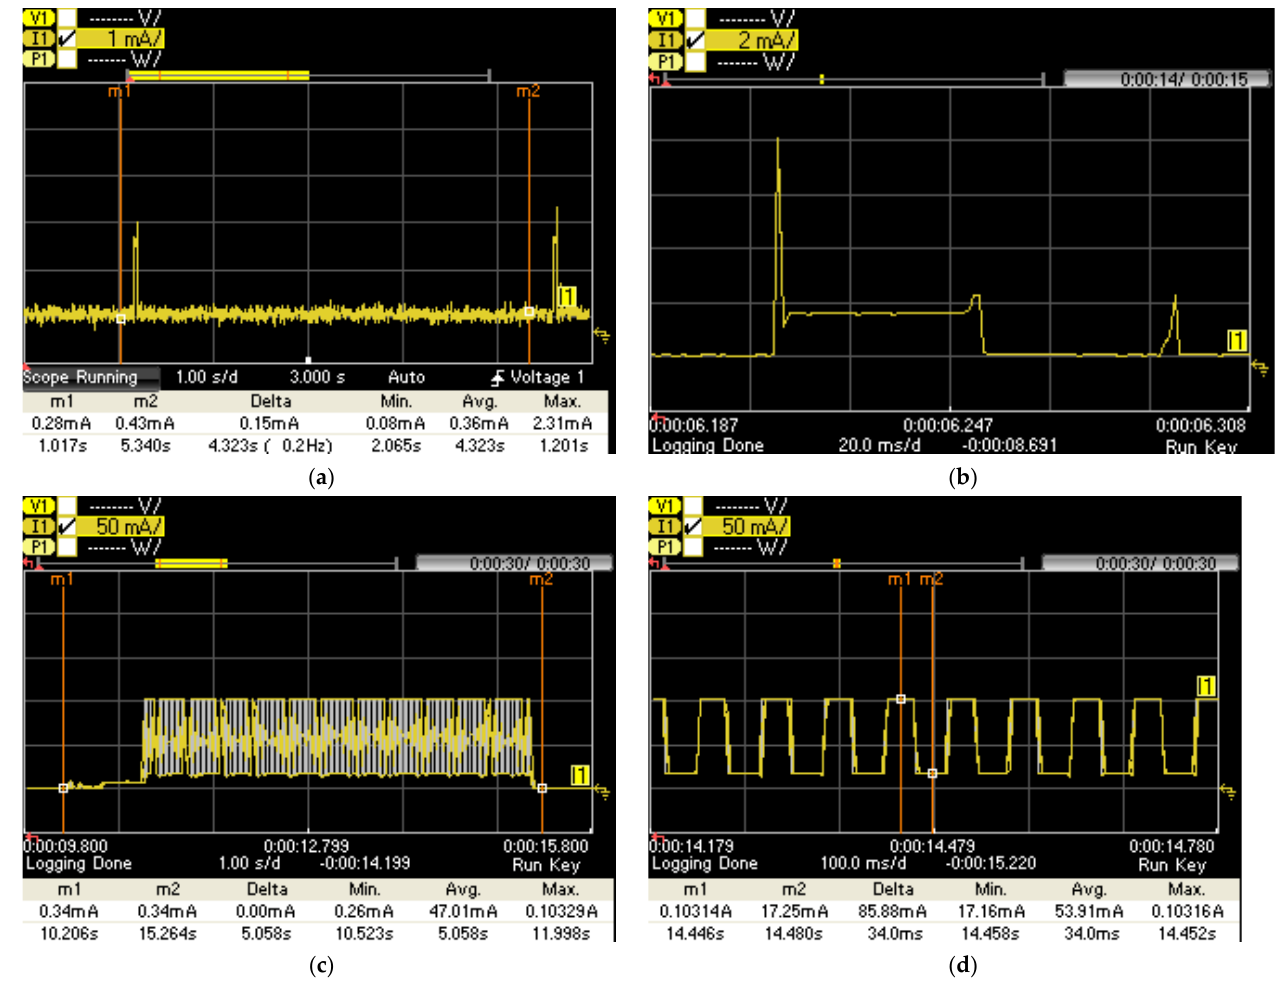
Figure 16. Screenshots of DC power analyzer for measuring current consumption of the sensor node: ( a ) markers covering the 4 s cycle with one peak current wave; ( b ) zoomed-in view of the peak current wave in ( a ); ( c ) markers covering the 5 s duration after a fire event; ( d ) zoomed-in view of the pulse-like wave in ( c ) after a fire event.